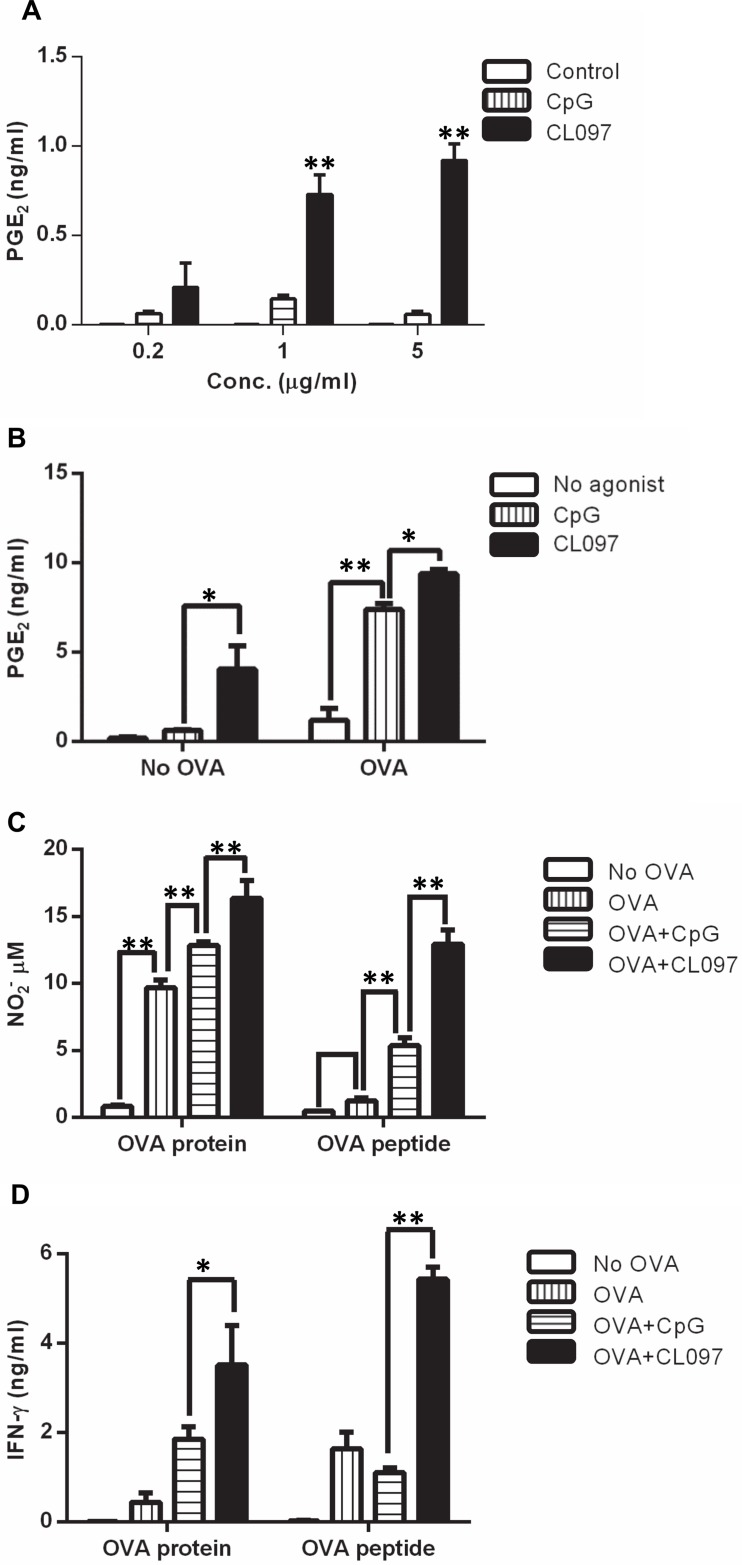
CL097 induces higher levels of PGE2, NO2
- and IFN-γ than CpG.(A) DCs were stimulated with CpG or CL097 at concentrations of 0.2, 1, and 5 μg/ml for 2 days, and PGE2 levels were measured from culture supernatants. Data shown are representative of two independent experiments. (B) OT-II CD4+ T cell/DC co-cultures were stimulated with OVA protein (25 μg/ml) in the presence or absence of 1 μg/ml CpG or CL097 for 3 days, and PGE2 levels were measured. Data shown are representative of two independent experiments. (C) OT-II CD4+ T cells/DC co-cultures were stimulated in the presence or absence of TLR agonists and OVA protein (25 μg/ml) for four days, and supernatants were collected to measure NO2
- by Griess assay. Data shown are representative of three independent experiments. (D) OT-II CD4+ T cells/DC co-cultures were stimulated in the same conditions mentioned above for 4 days, and supernatants were collected to measure IFN-γ by ELISA. Data shown are representative of three independent experiments. Statistical differences between treatments were analyzed with one-way ANOVA. The graph shows the mean ± SD of triplicate wells. *p<0.05; **p<0.005.